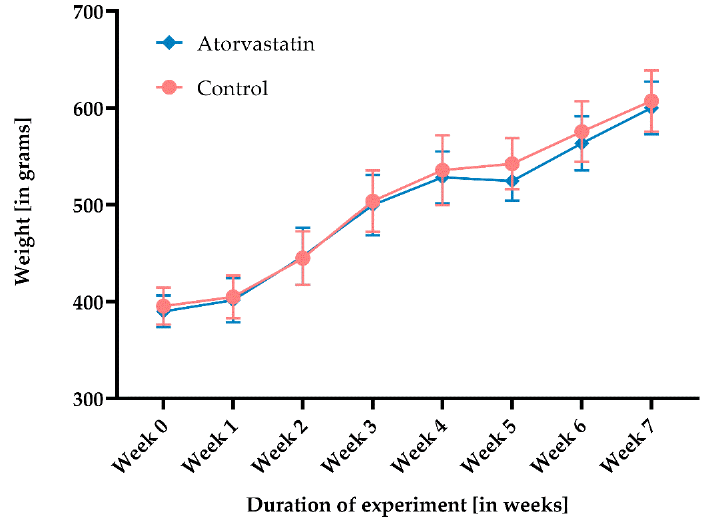
Figure 2 . Weight development of rats in the course of the study without differences between atorvastatin and the control (total number: n = 48 by the end of week 2, n = 32 by week 4, and then n = 15).